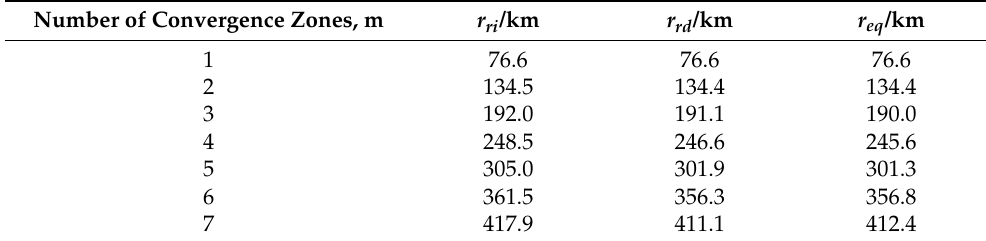
Table 1. Positions of convergence zones obtained using proposed formulation and coupled normal mode. Number of Convergence Zones,